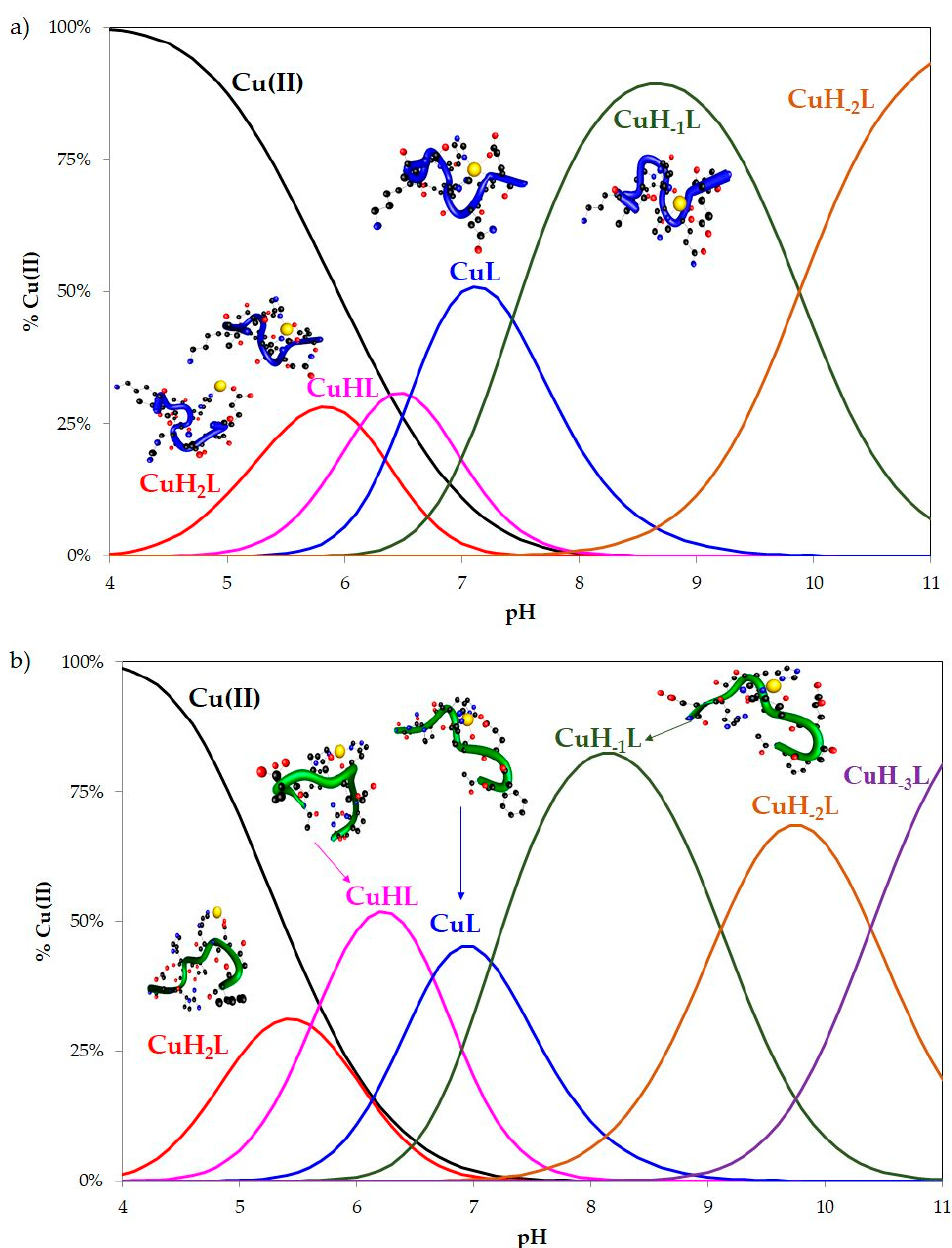
Figure 1. Species distribution diagram for the ( a ) Cu(II)-Ac-AKGHEHQLE-NH 2 system (L 2 ) and ( b ) Cu(II)-Ac-FGEHEHGRD-NH 2 (L 2 ) system. Cu(II):L 1:1.1, [Cu(II)] = 1 mM. Overall stability constants determined at 25 °C and at 0.1 M ionic strength (KCl).